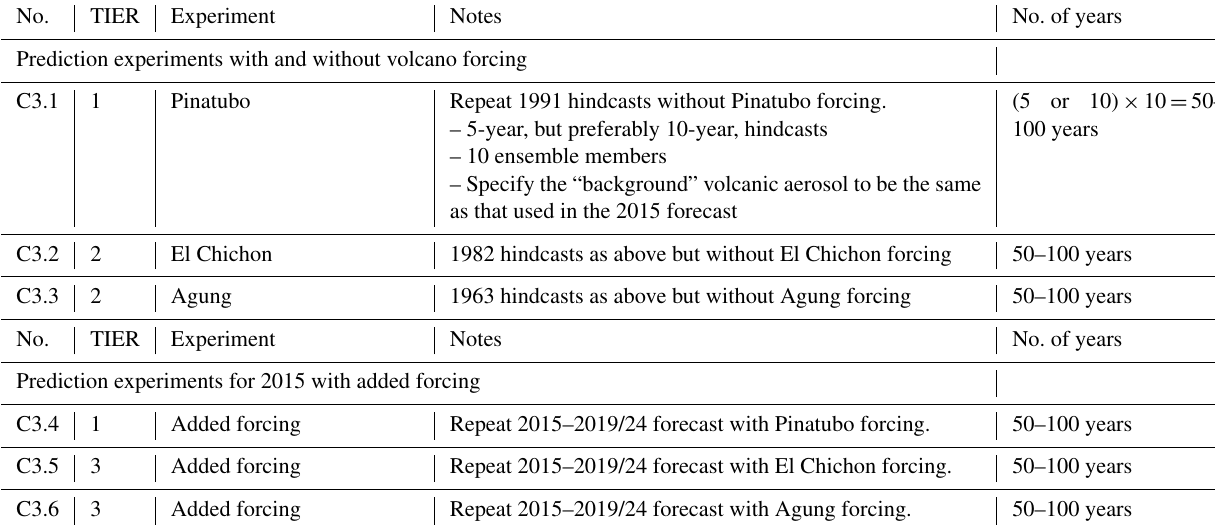
Table C3. Volcano effects on decadal prediction. No.